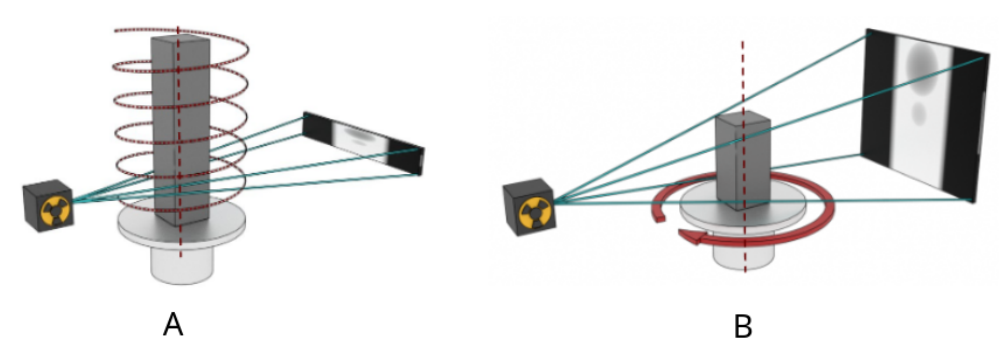
Figure 4. Images of two measurement schemes: ( A ) helical scheme, ( B ) circular